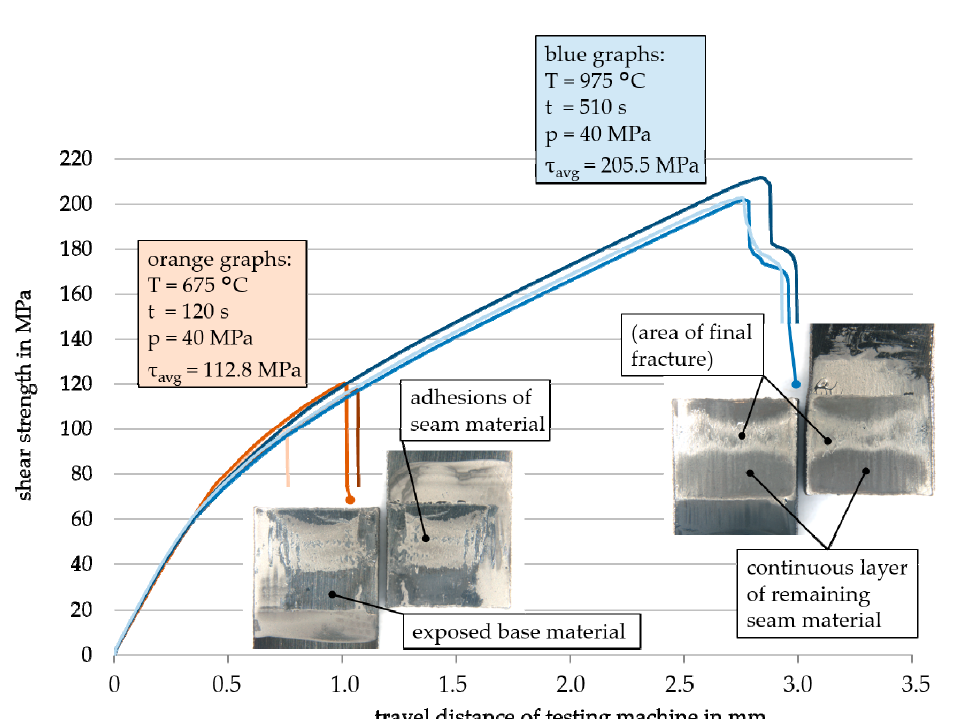
Figure 6. Strain curves for joint samples of two parameter sets (differentiated by orange and blue shades), in which the fracture surface of one sample is shown to indicate the different failure behaviors (base material: IN 718_am, nanopaste: Ni90_T_KD4).